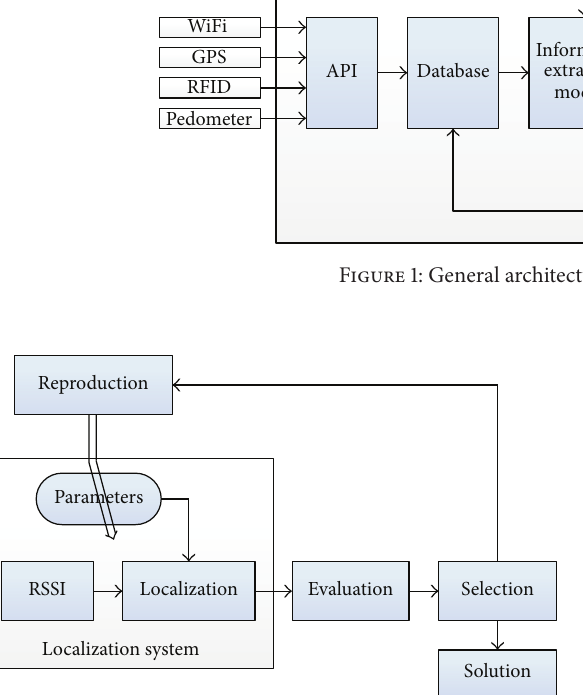
Figure 2: Optimization of system parameters using GAs.